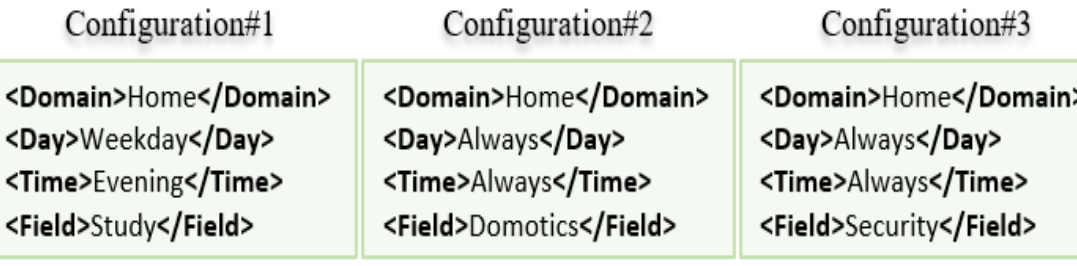
Figure 9. Explicit preferences for the first scenario.